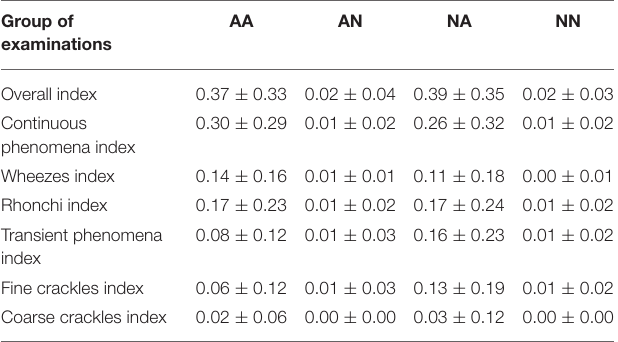
TABLE 3 | Mean and standard deviation of each index value within each group of examinations. Group of